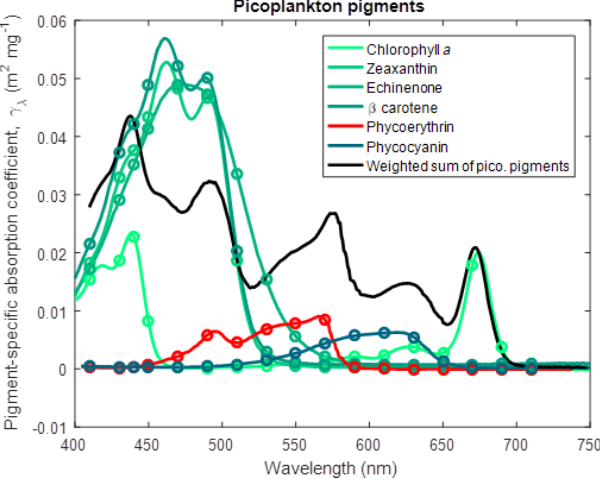
Figure 6. Pigment-specific absorption coefficients for the dominant pigments found in large phytoplankton and microphytobenthos de- termined using laboratory standards in solvent in a 1cm vial. The aqua line represents the weighted sum of the photosynthetic pig- ments (Eq. 4), with the weighting calculated from the ratio of each pigment concentration to chlorophyll a . See Fig. 5 for more details. Fucoxanthin was dissolved in ethanol.